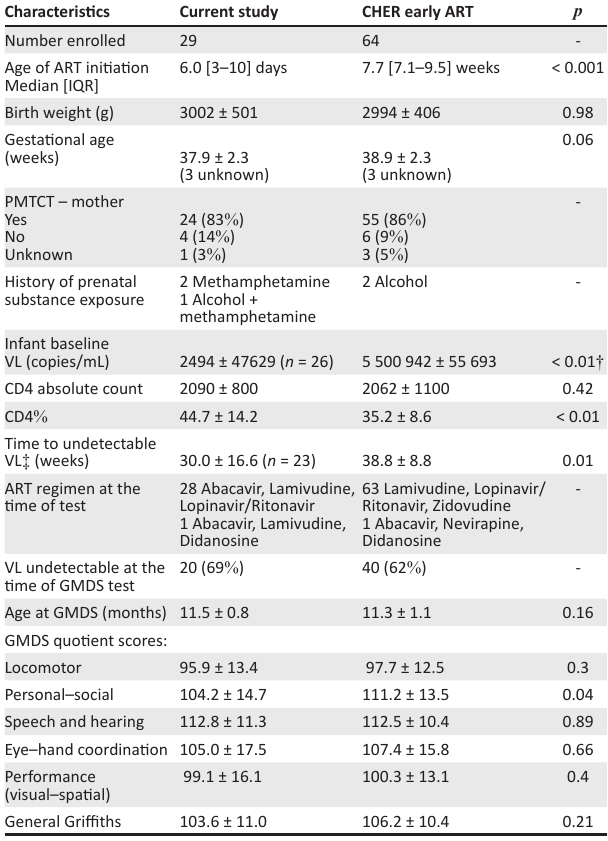
TABLE 5: Comparison between study participants and Children with HIV Early antiRetroviral early treatment participants. 10